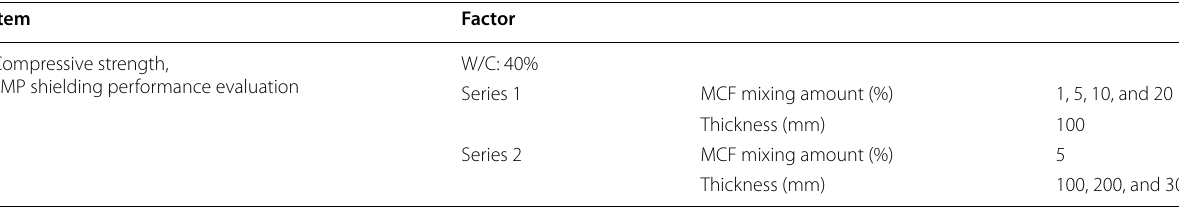
Table 1 Experimental